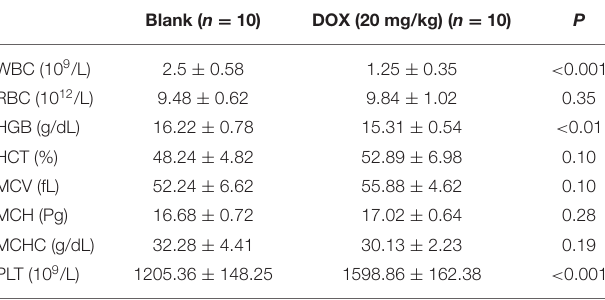
TABLE 2 | Hematologic parameters in rats treated with DOX or